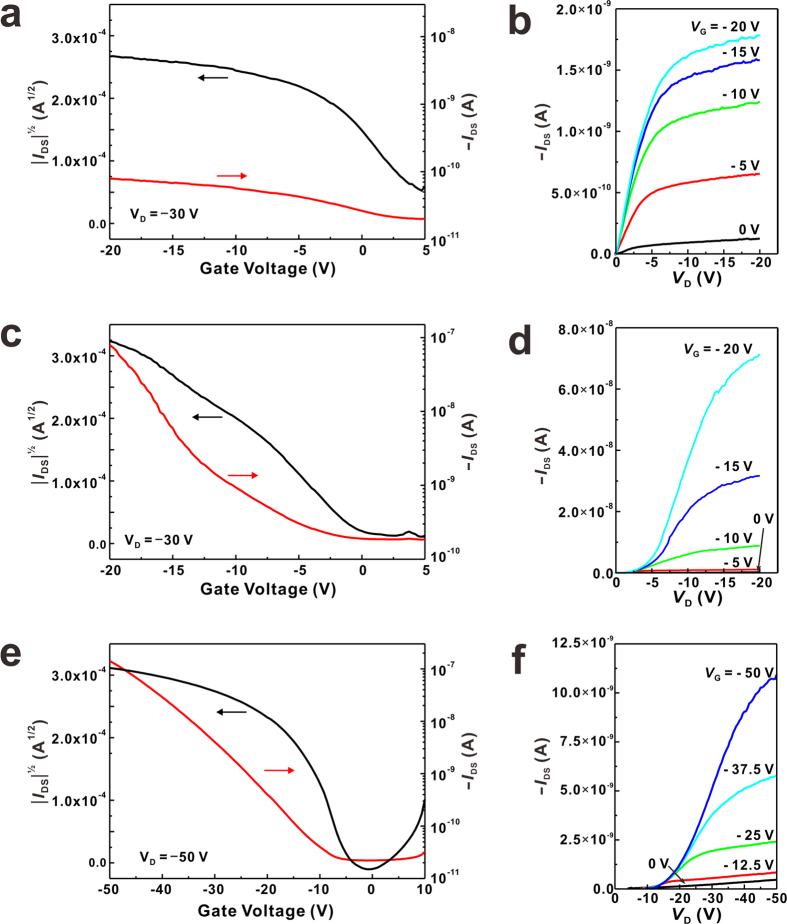
Representative transfer and output curves of OFET using (a,b) RB-NWBA, (c,d) RB-NWTCB, and (e,f) RB-NWSA.